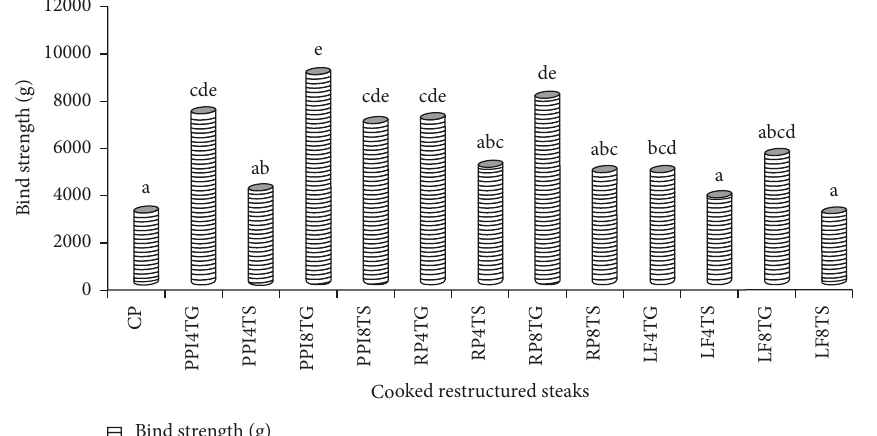
Figure 1: Bind strength among protein-enriched restructured beef steaks. control (CP), pea protein isolate (PPI), rice protein (RP), and lentil flour (LF) (at 4 and 8%); binding agents: Activa EB (TG) and Transgluseen-M